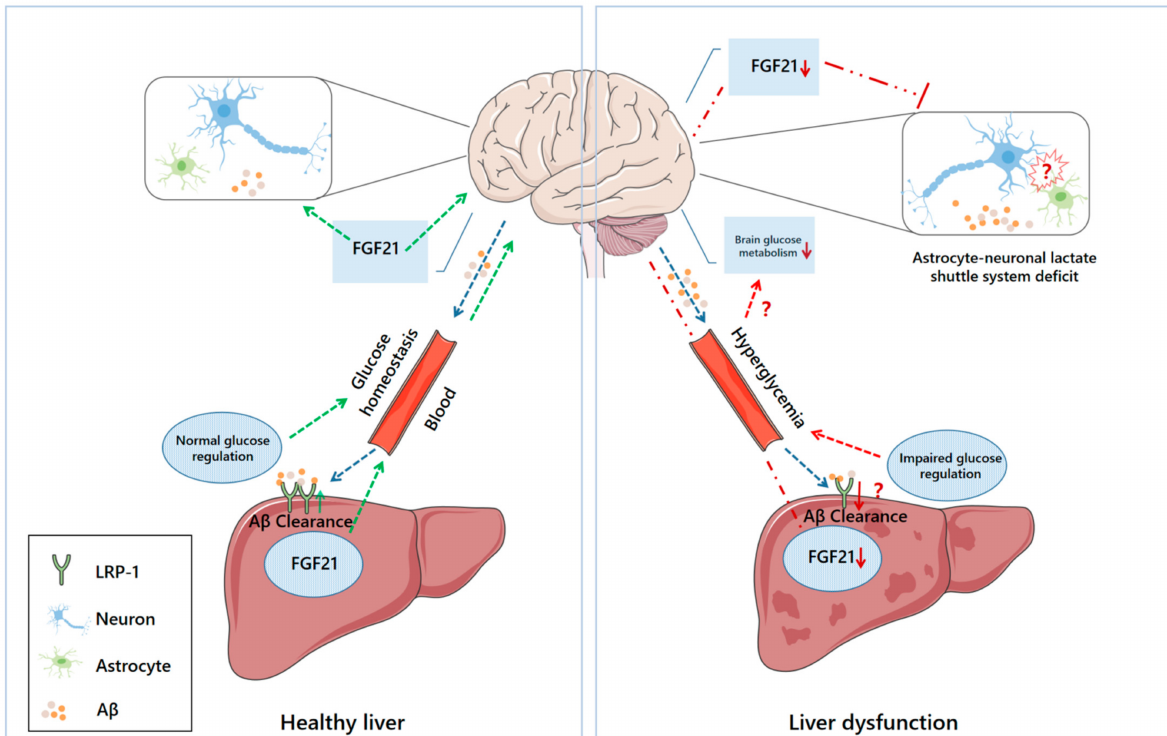
Figure 1. The potential communication between liver dysfunction and AD